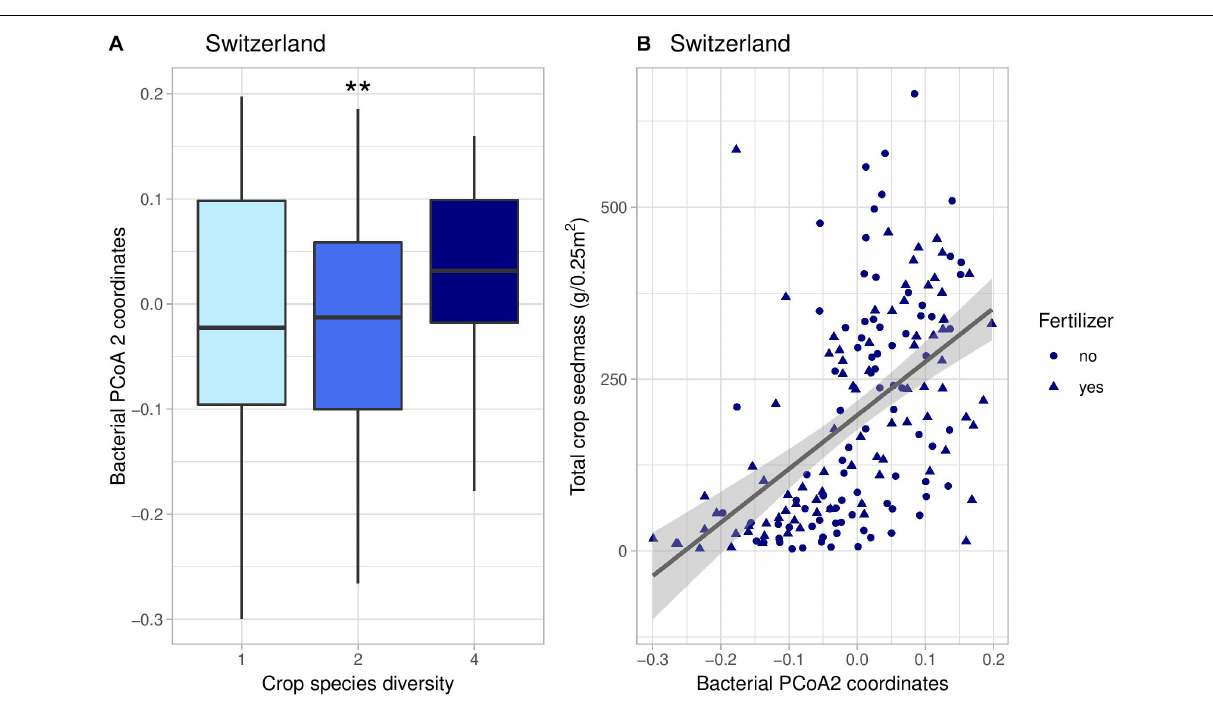
FIGURE 5 | Effects of crop species number on the coordinates of the second axis of bacterial PCoA decomposition (A) and correlation between these coordinates and total crop yield (B) in Switzerland. In panel (B) , the line represents the linear regression (coefficient: 779, p -value < 0.001). **indicates the significance level of the effects of crop species number on bacterial PCoA 2 ( p -value <